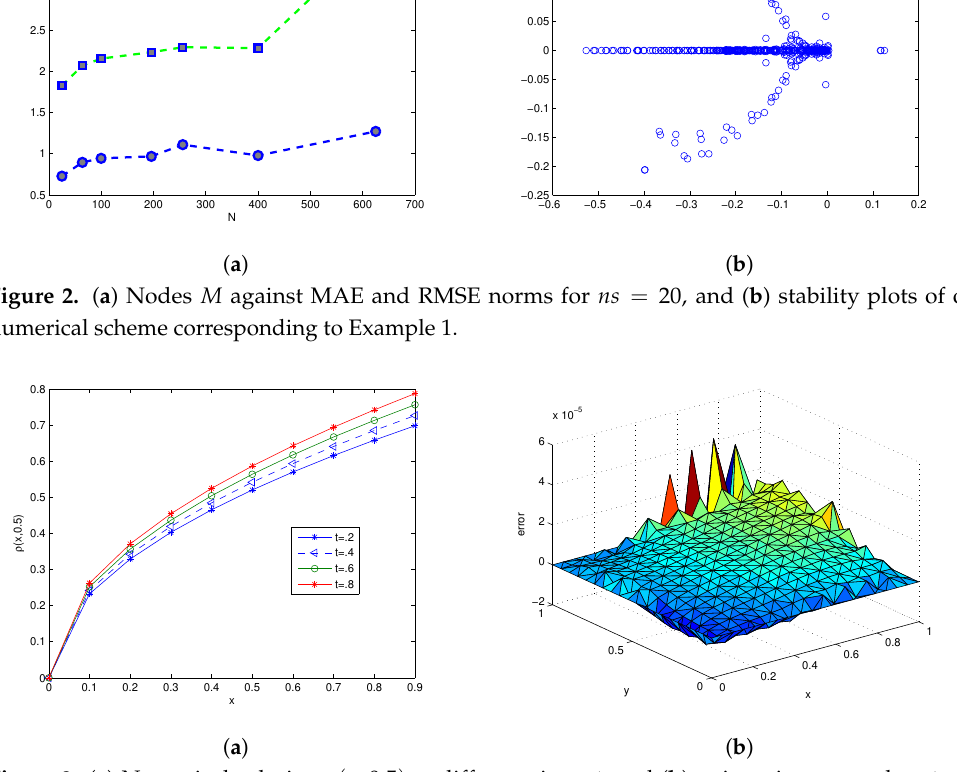
Figure 3. ( a ) Numerical solution ρ ( x ,0.5 ) at different times t , and ( b ) point wise error when t = 1, ns = 20 and δ = 0.0001 when M = 400 corresponding to Example